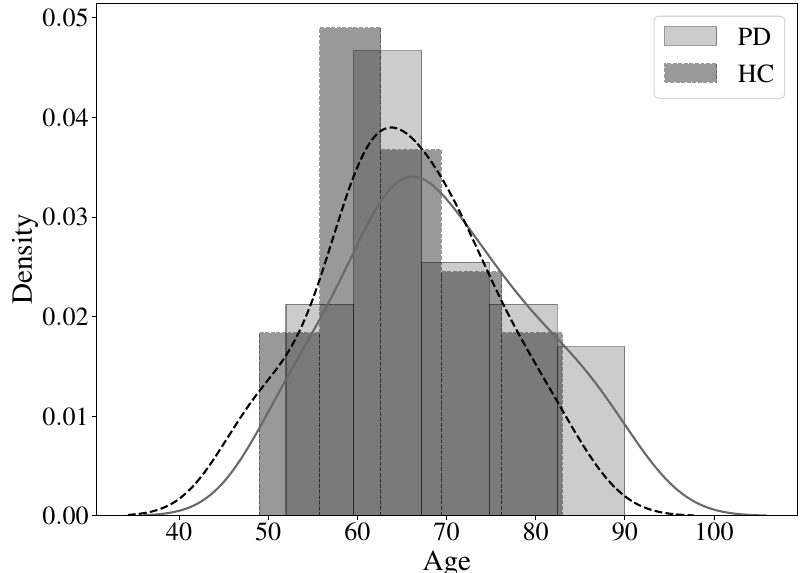
Figure 4. Age distribution for both HC and PD.